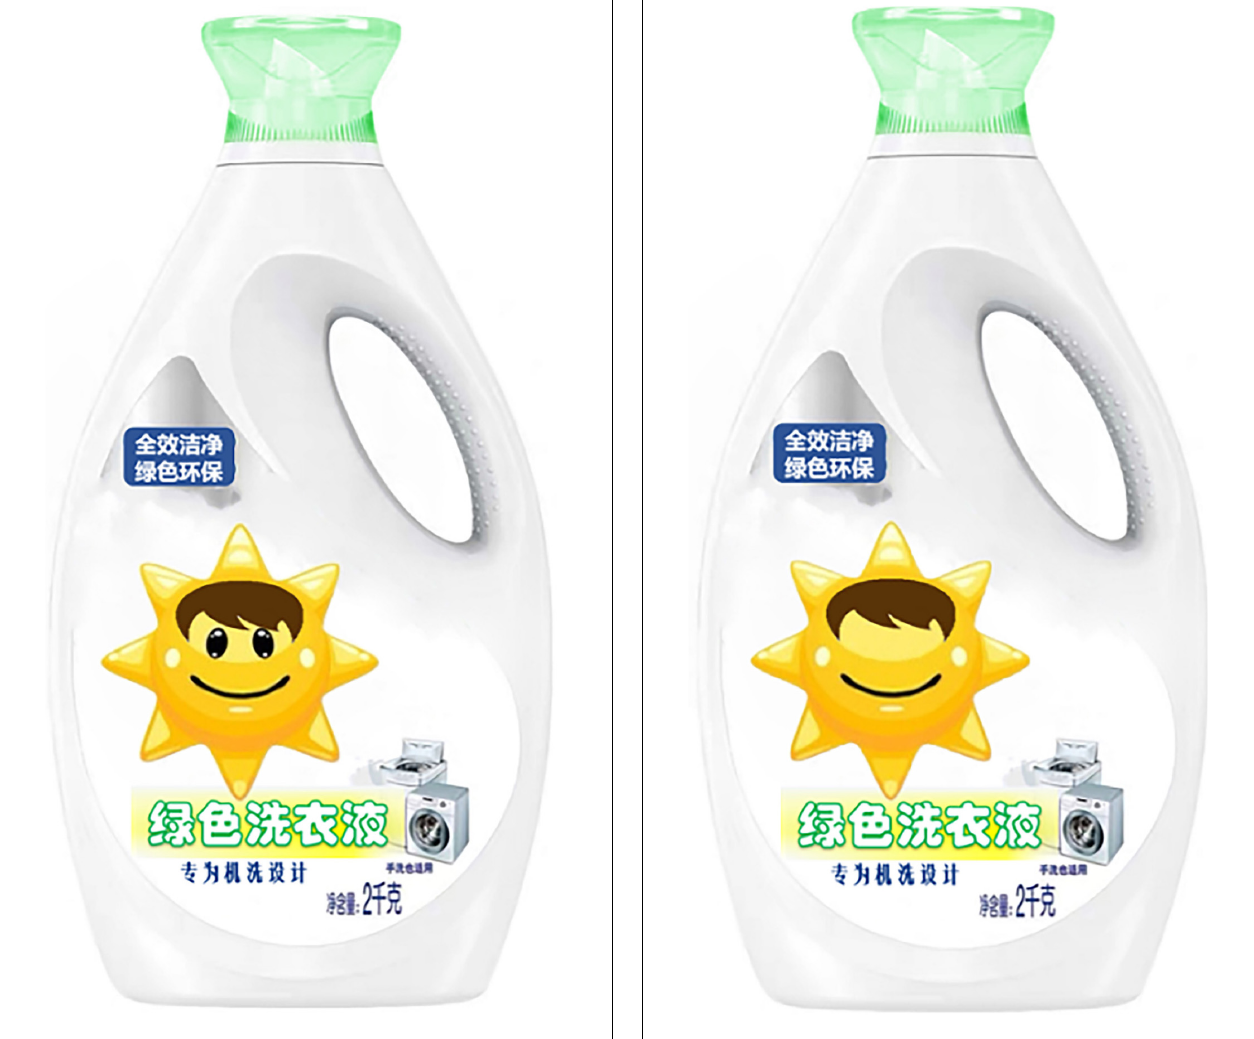
more representative green air conditioner (Lao, 2013) was selected as a stimulus for study 3.